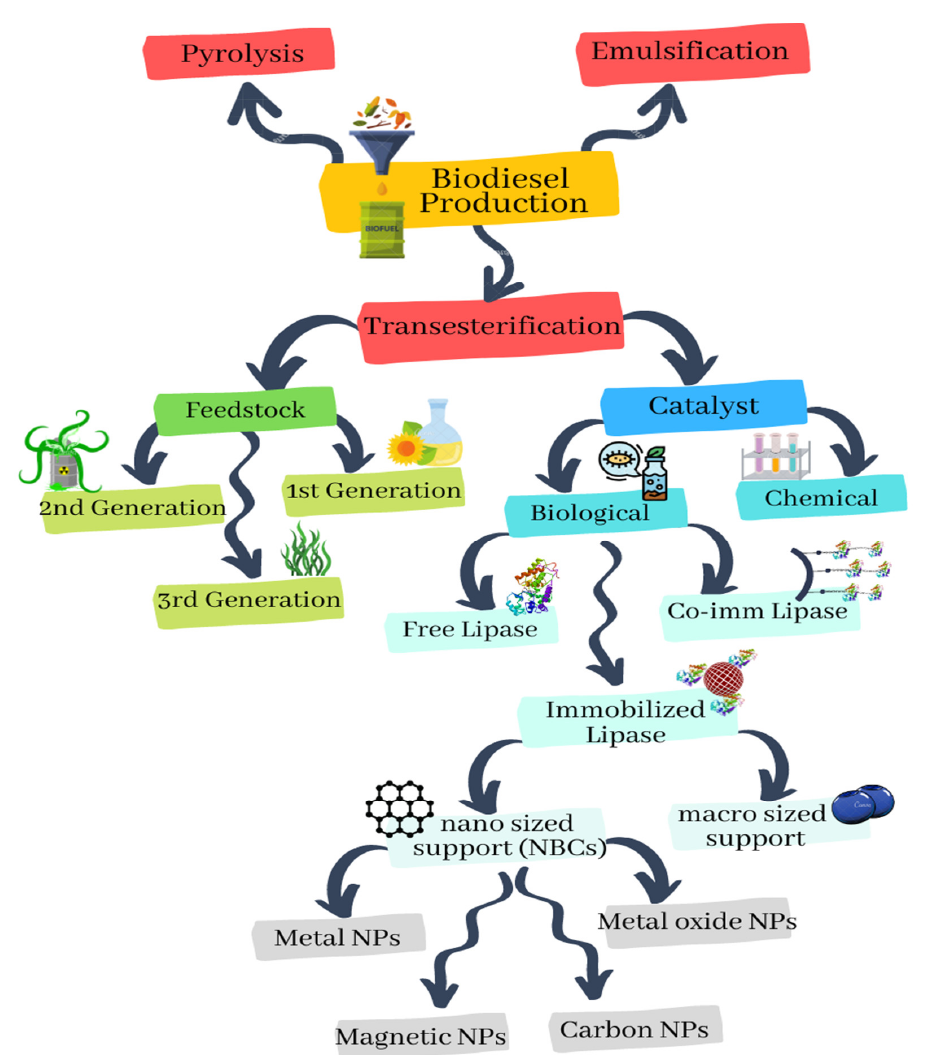
Figure 2. Fundamentals of biodiesel production through enzymatic transesterification.